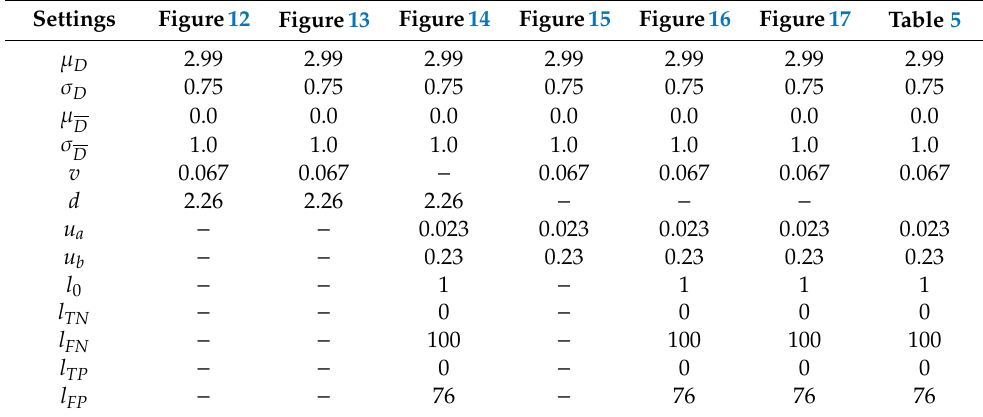
Table 4. The parameter settings of Figures 12–17 and Table 5.